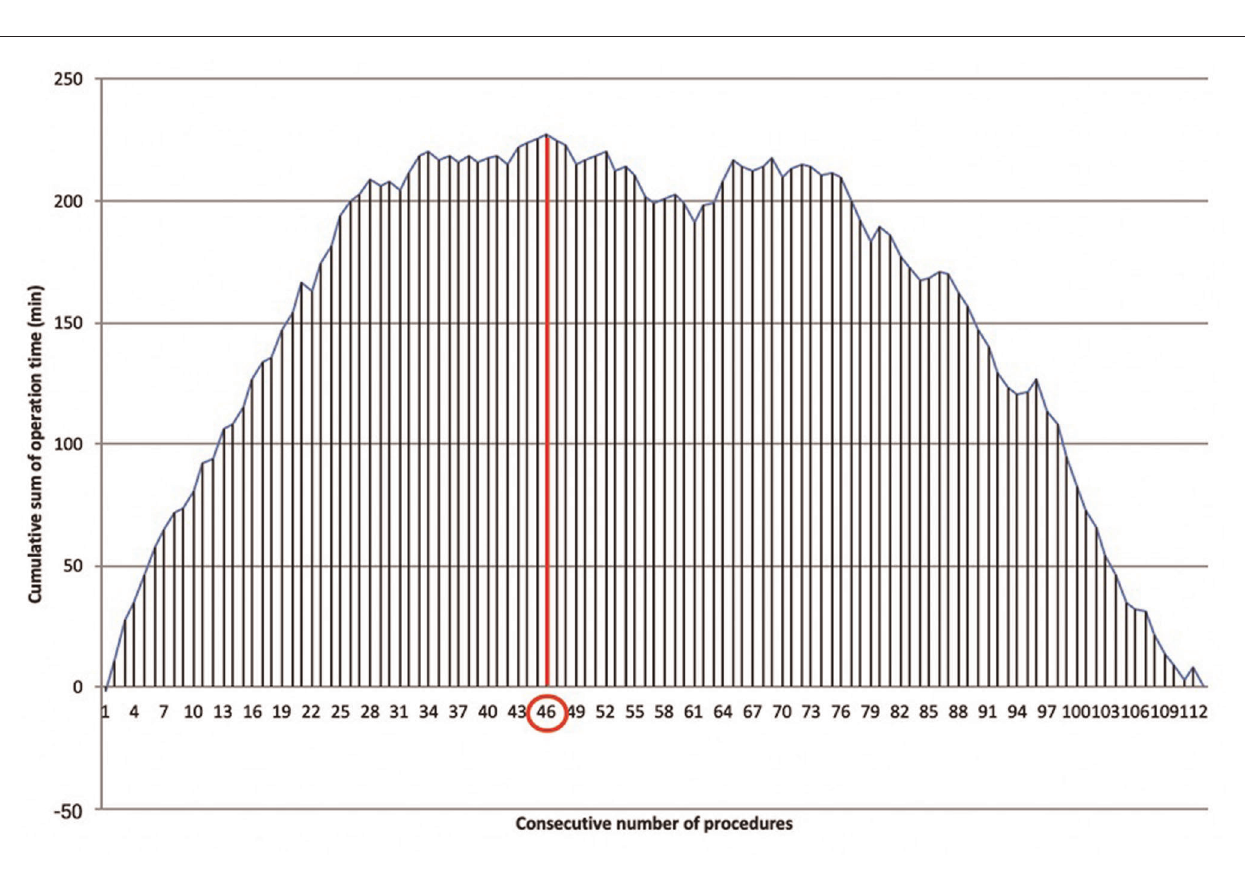
FIGURE 6 | Learning curve of robotic docking time. Cumulative sum (CUSUM) plot for the overall docking time. The red circle is the CLC cut-off value on the plot of CUSUM analysis. CLC, completion of learning